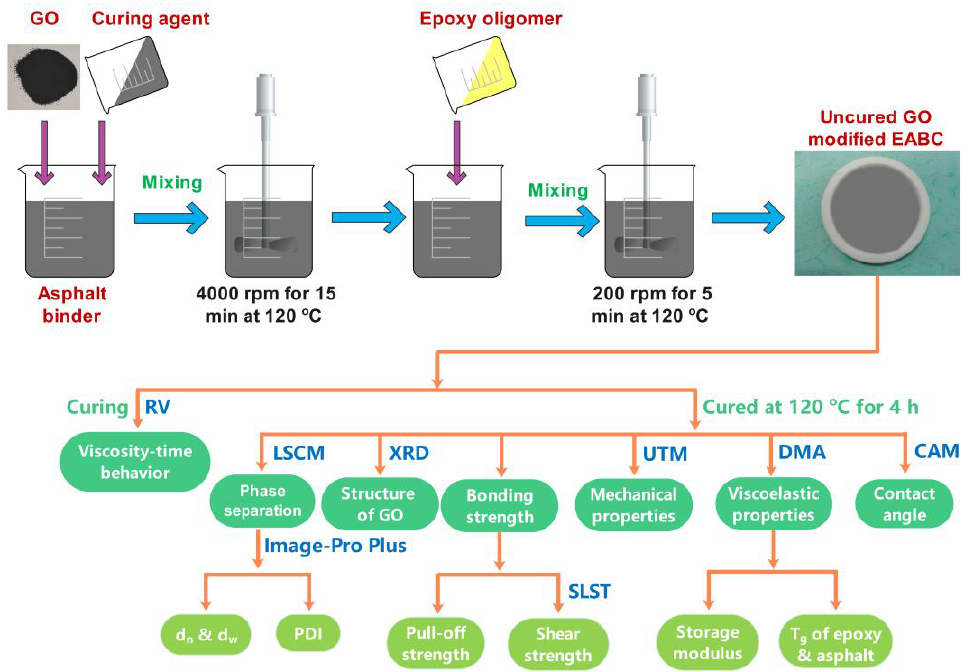
Figure 1. Schematic illustration for the preparation and characterization of GO-modified EABCs.